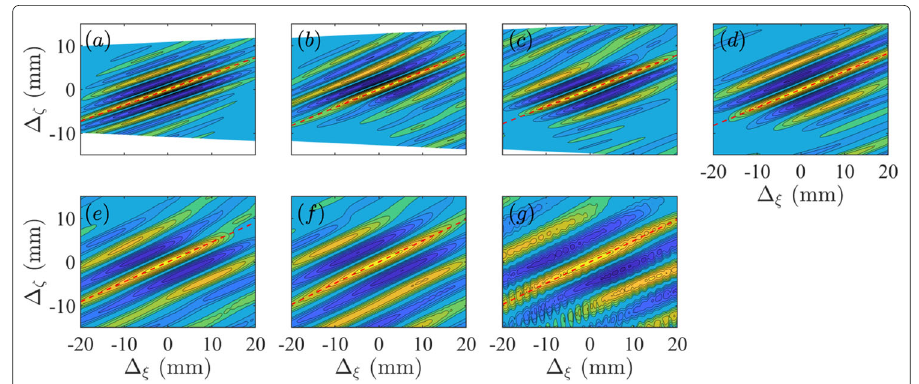
(cid:3) (cid:2) (cid:7) ξ , (cid:7) ζ ,0 Fig. 13 C pp for low-frequency wall pressure at probe points in Group 1. Contour levels